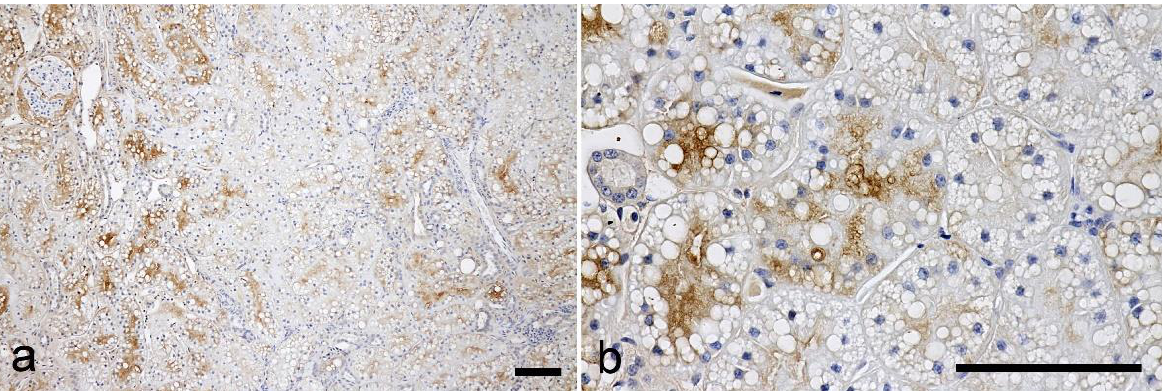
Figure 4. Histochemical staining for Ricinus communis agglutin I (RCA-I) in the feline kidney. ( a ) Low magnification view of the corticomedullary junction. A stronger staining intensity can be observed in the brush border of the proximal straight tubules (PSTs) than those of the proximal convoluted tubules (PCTs). ( b ) High magnification view of the inner medulla. Positive labelings are seen in the CDs and thin limbs (TLs). Scale bars: 100 μm.